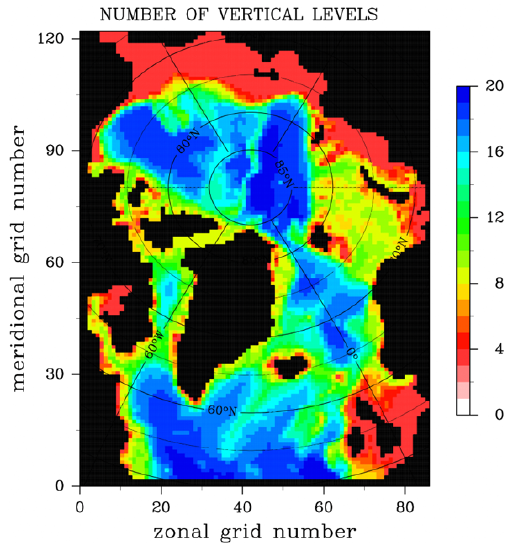
Fig. 1. Bottom topography of the